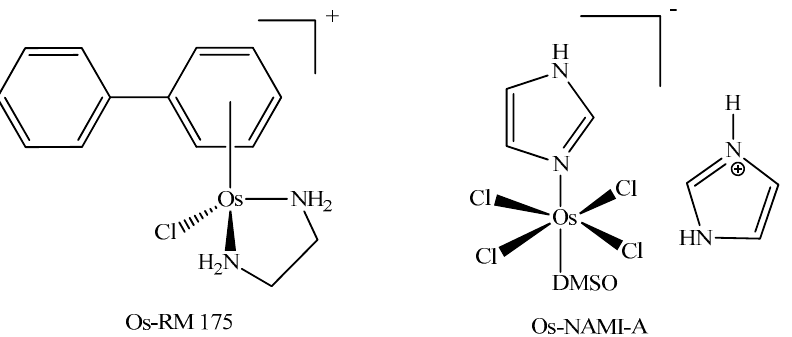
Figure 6. Chemical structures of the complexes Os-RM175 and Os-NAMI-A (DMSO = dimethyl sulfoxide). Adapted from [62] with permission from the journal RSC Adv. , Copyright © 2019.